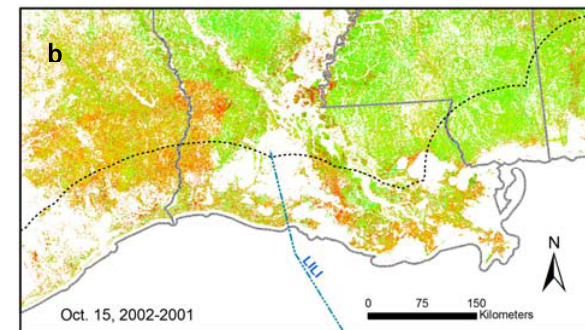
Figure 11. (a and c) Percentage changes of MODIS EVI values in the years without hurricane disturbance. (b and d) Changes in the EVI value after Hurricane Lili made landfall on October 3, 2002. The map legend is the same as Figure